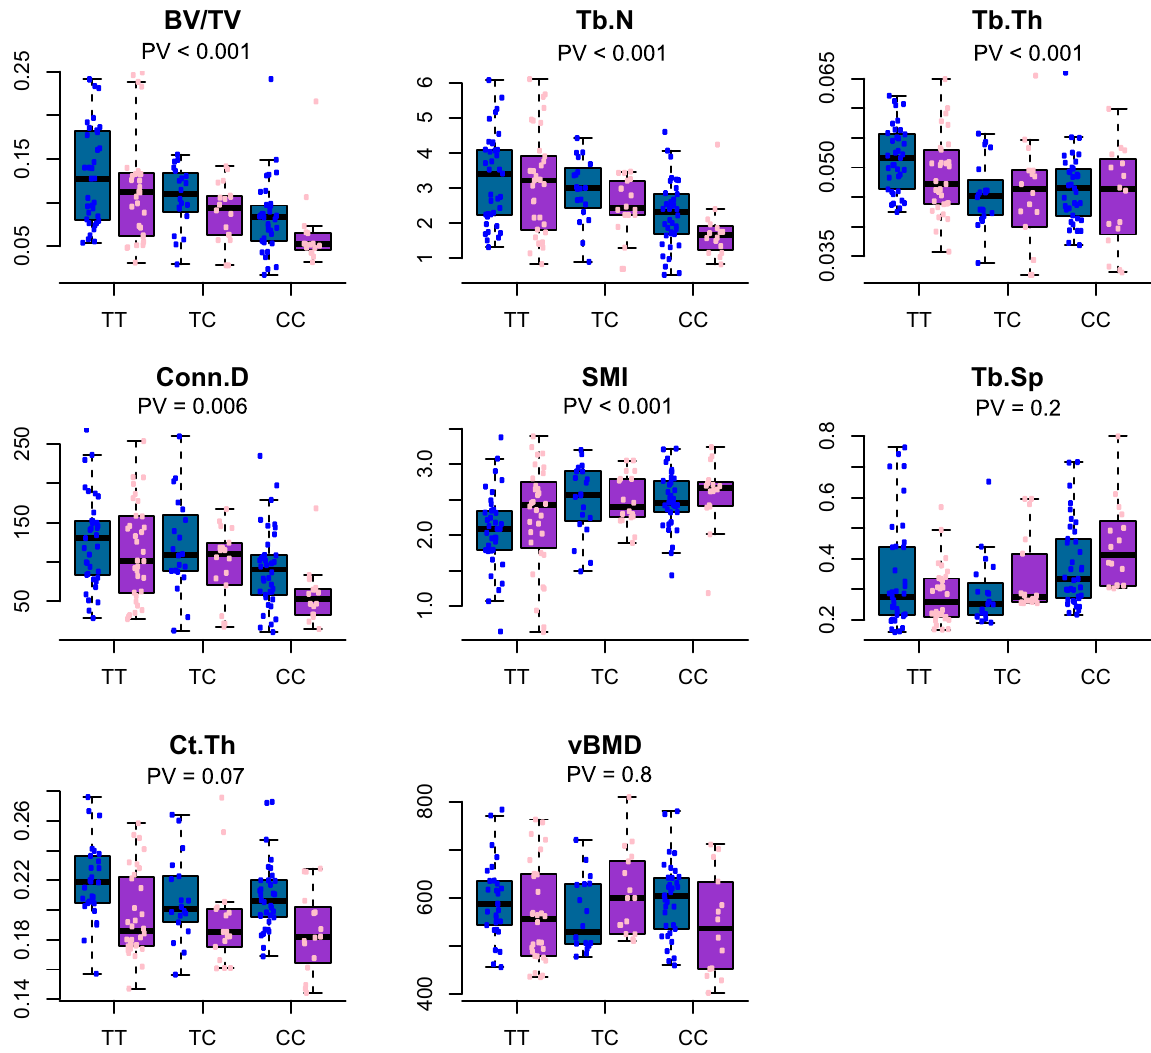
Figure 3. Allelic variants at Tlr7 . Distribution of traits at the marker JAX00032223 across bearers of homozygous and heterozygous alleles, separated by sex. The x-axis is the allelic variation at the marker; the y-axis represents the trait value. PV denotes the P -value determined by multi-way ANOVA with the examined trait as the dependent variable and the covariates as independent